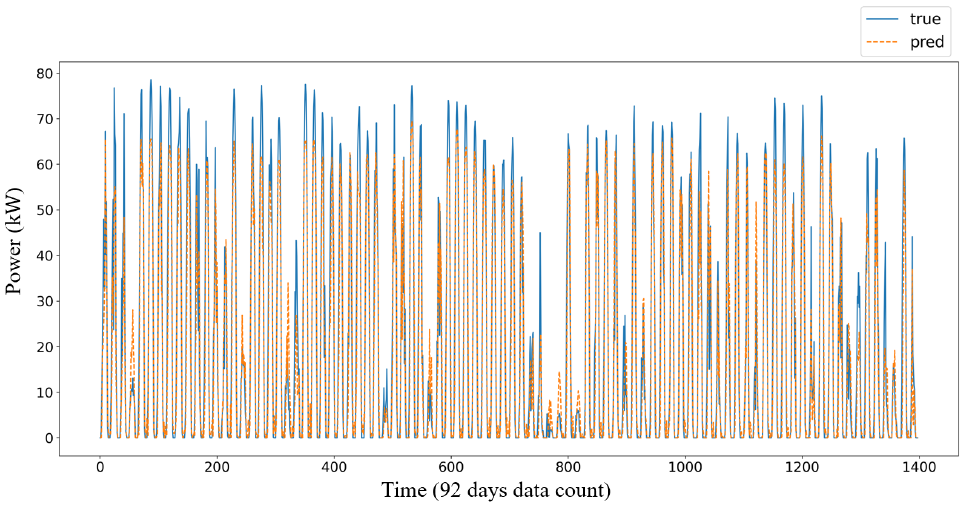
Figure 12. Prediction test used the SPV Plant irradiance of Vision College SPV